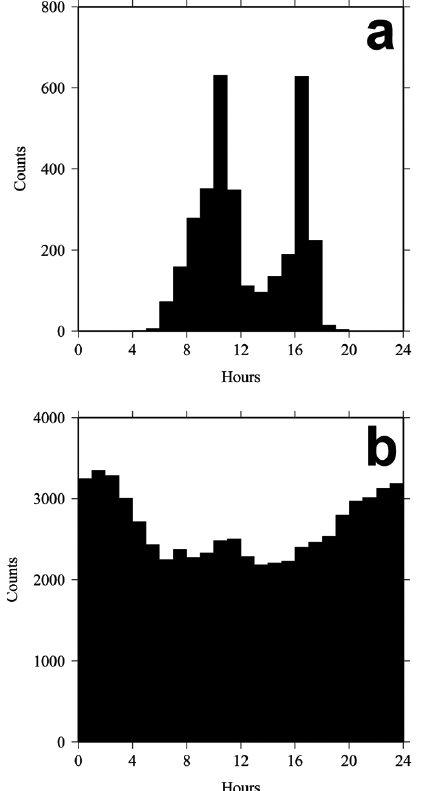
Figure 7. Histogram of the hourly distribution (UTC time = local time – 1): (a) of the seismicity classified as “quarry blasts”; (b) of the seismicity classified as “tectonic events”. In (a), the trend detected in Figure 4 is confirmed, and no events outside the day hours are in- cluded. In (b), events during the night are marginally more frequent, due to the lower ambient noise and thus better network detection.